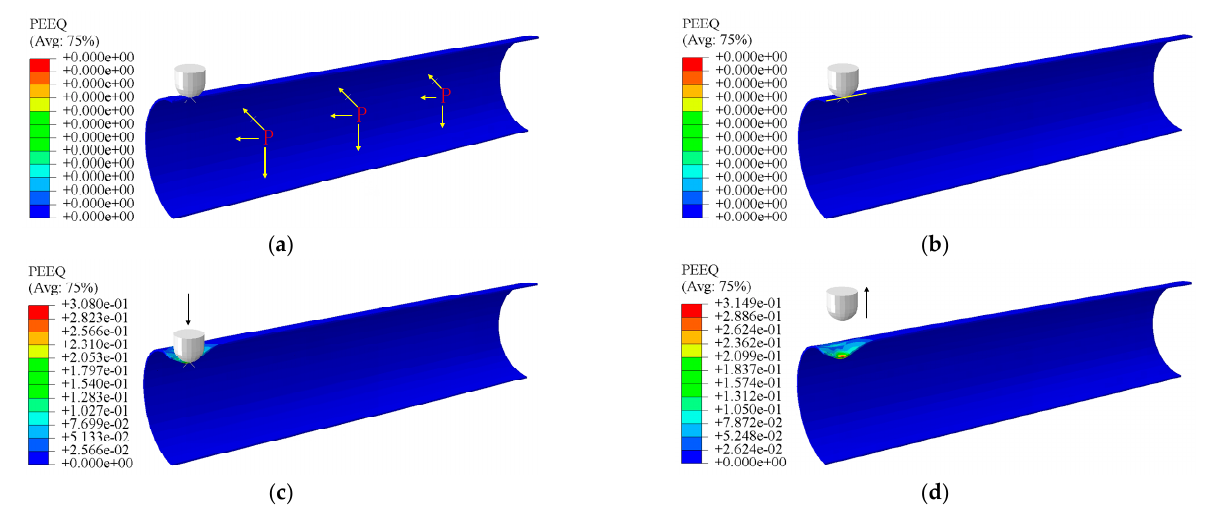
Figure 11. Analysis of steps setting: ( a ) internal pressure load, ( b ) setting the contact, ( c ) the displacement load, ( d ) the rebound of the dent.